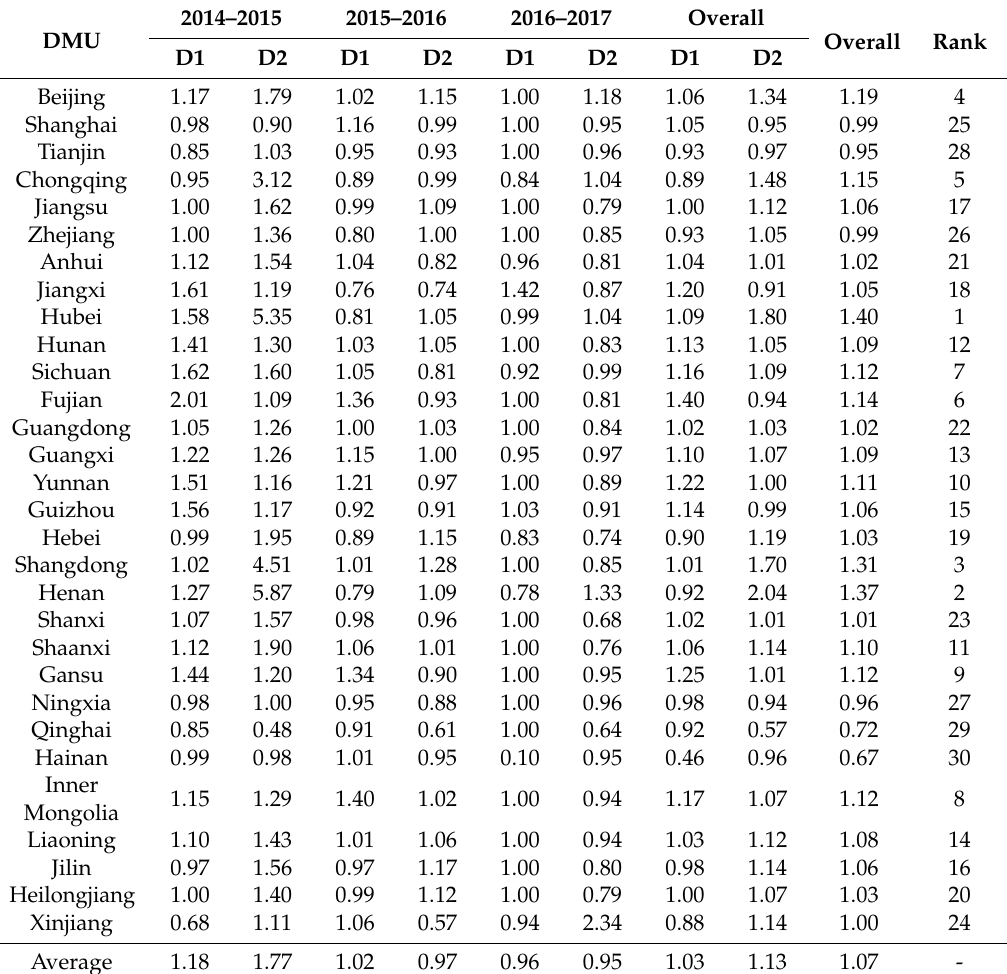
Table 6. Malmquist productivity index of China’s provincial